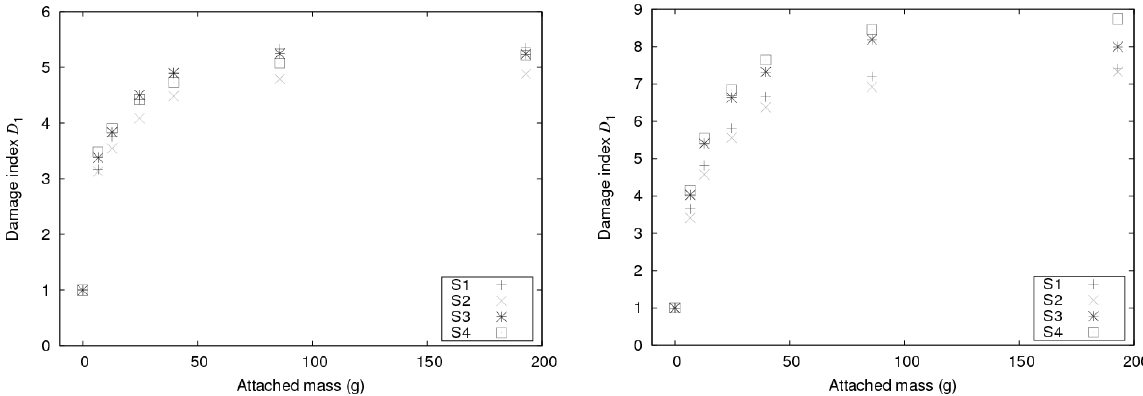
Fig. 4. Damage index D 1 for sensors S1, S2, S3 and S4 using A1 (left) and A2